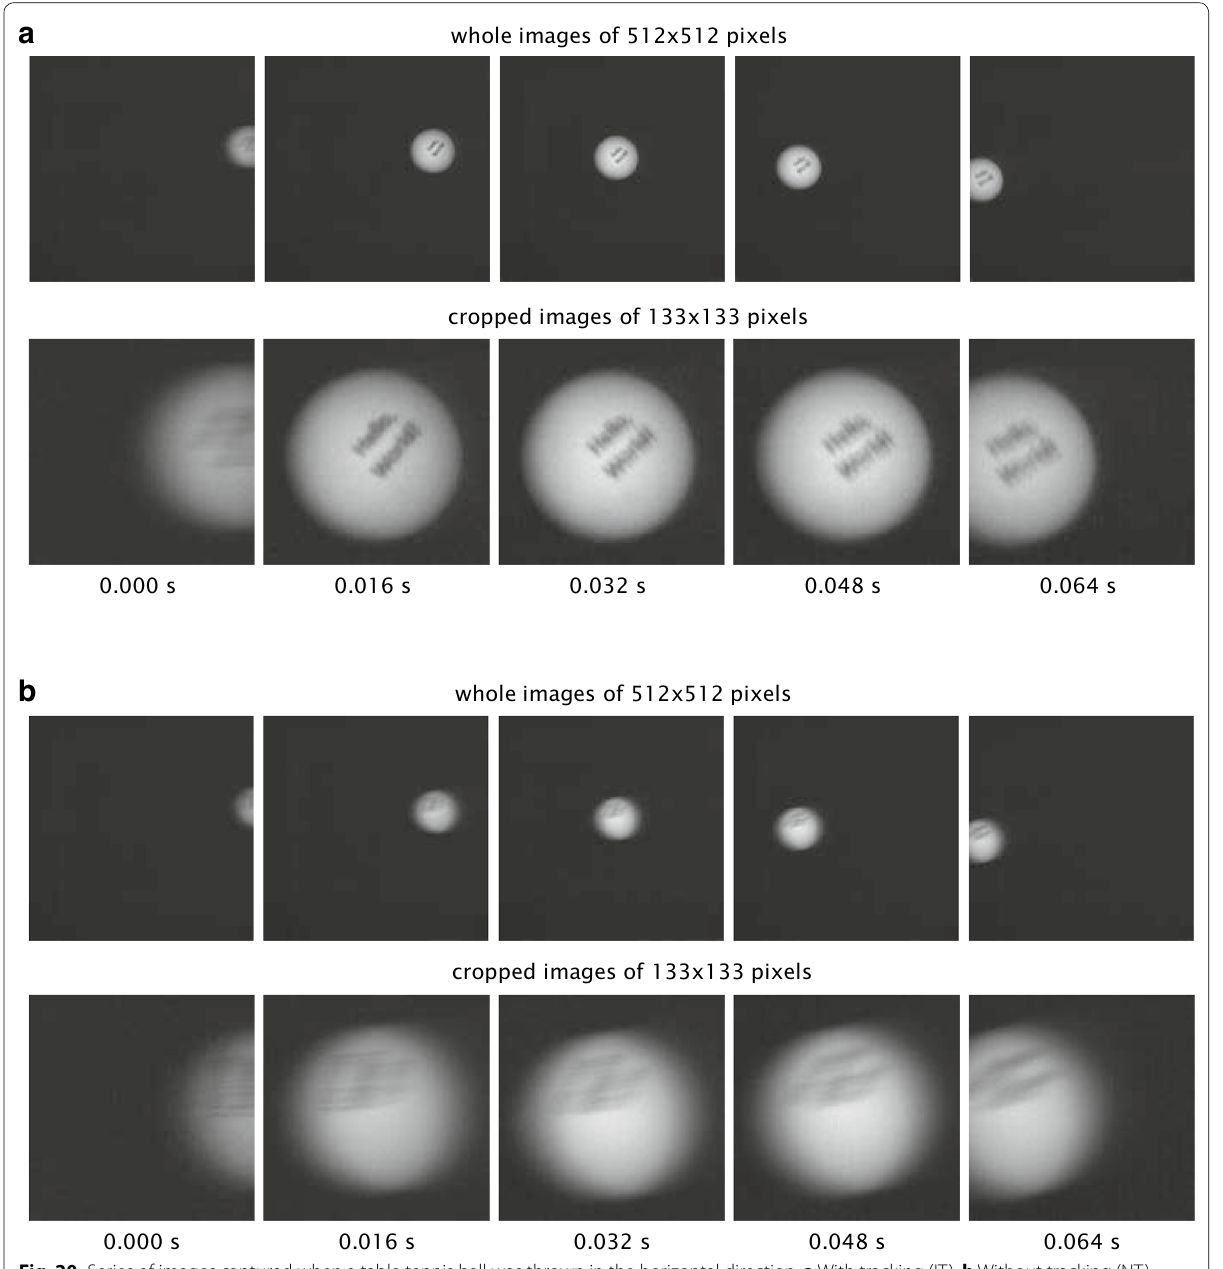
Fig. 20 Series of images captured when a table tennis ball was thrown in the horizontal direction. a With tracking (IT). b Without tracking